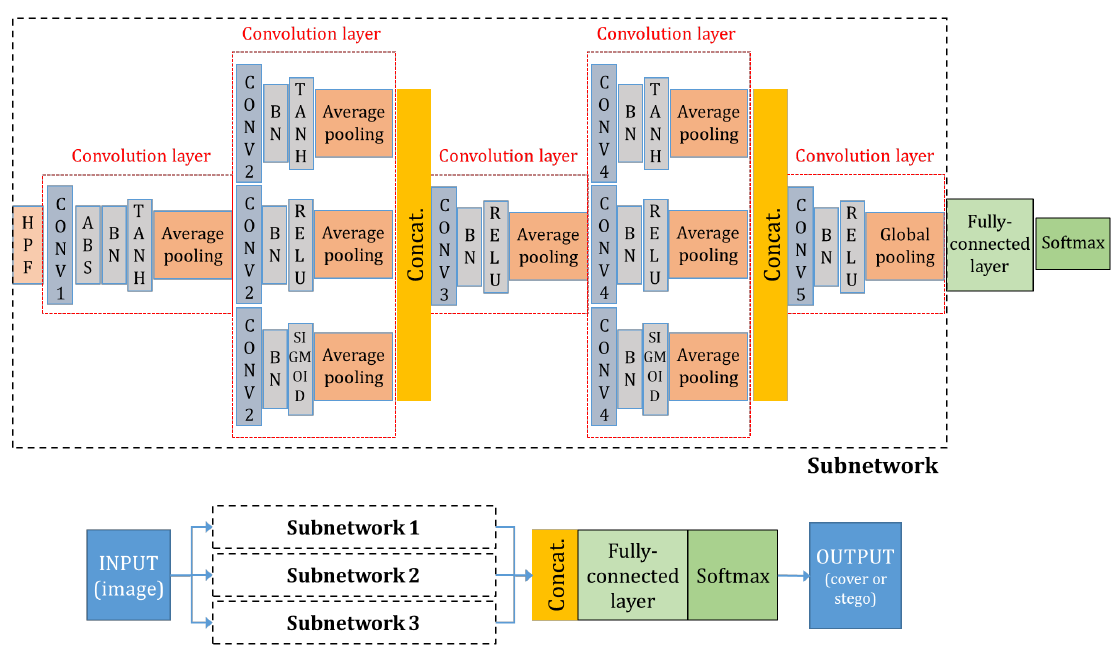
Figure 6. Structure of Rest-Net [19], which comprises three three subnetworks that are a modification of the initial CNN [17] and uses transfer learning.